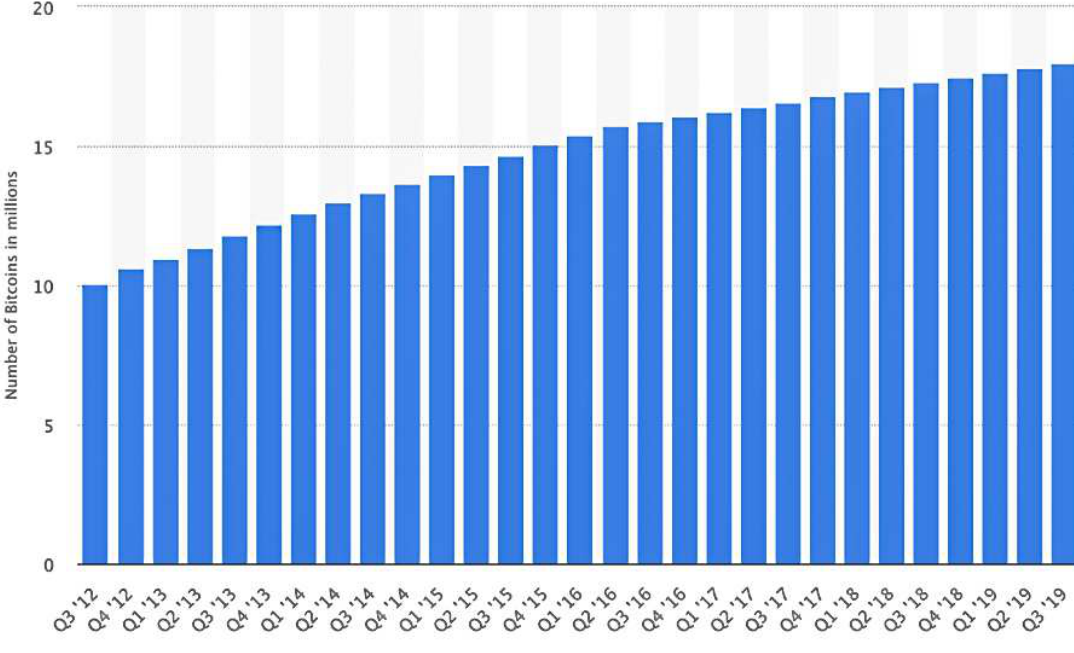
Figure 2. The number of Bitcoin in circulation worldwide from 3rd quarter 2012 to 3rd quarter 2019 (in